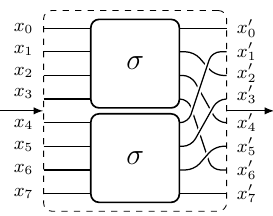
Figure 6: The Construction of the 8-bit S-Box Σ of QARMA -128